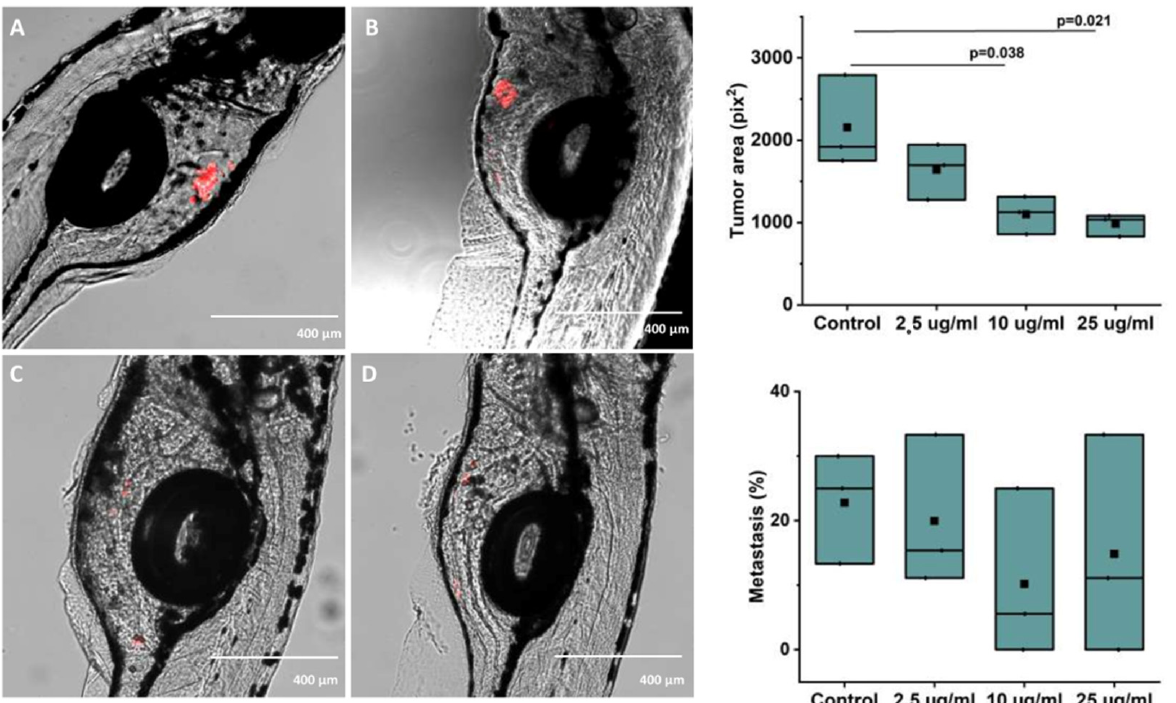
Figure 5. ( A – D ): Representative images of zebrafish microinjected with labelled HSC-3 cells and treated with ( A ): Control (embryonic media only), ( B ) 2.5 µ g/mL, ( C ) 10 µ g/mL, or ( D ) 25 µ g/mL of whole bilberry powder in embryonic media. E: Tumor area and F: Metastasis as group averages from 3 independent experiments (33–38 fish per group in the 3 experiments combined) after treatment with different concentrations of bilberry powder.